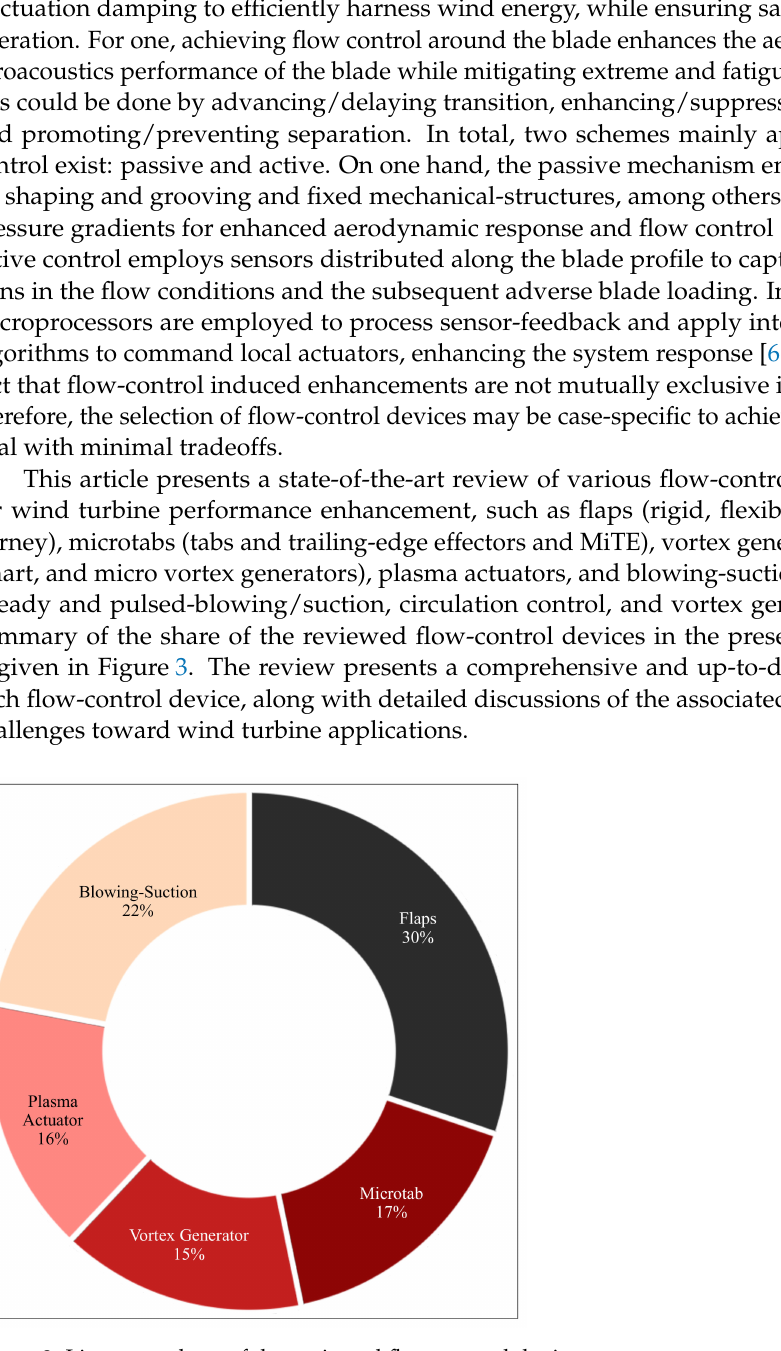
Figure 3. Literature share of the reviewed flow-control